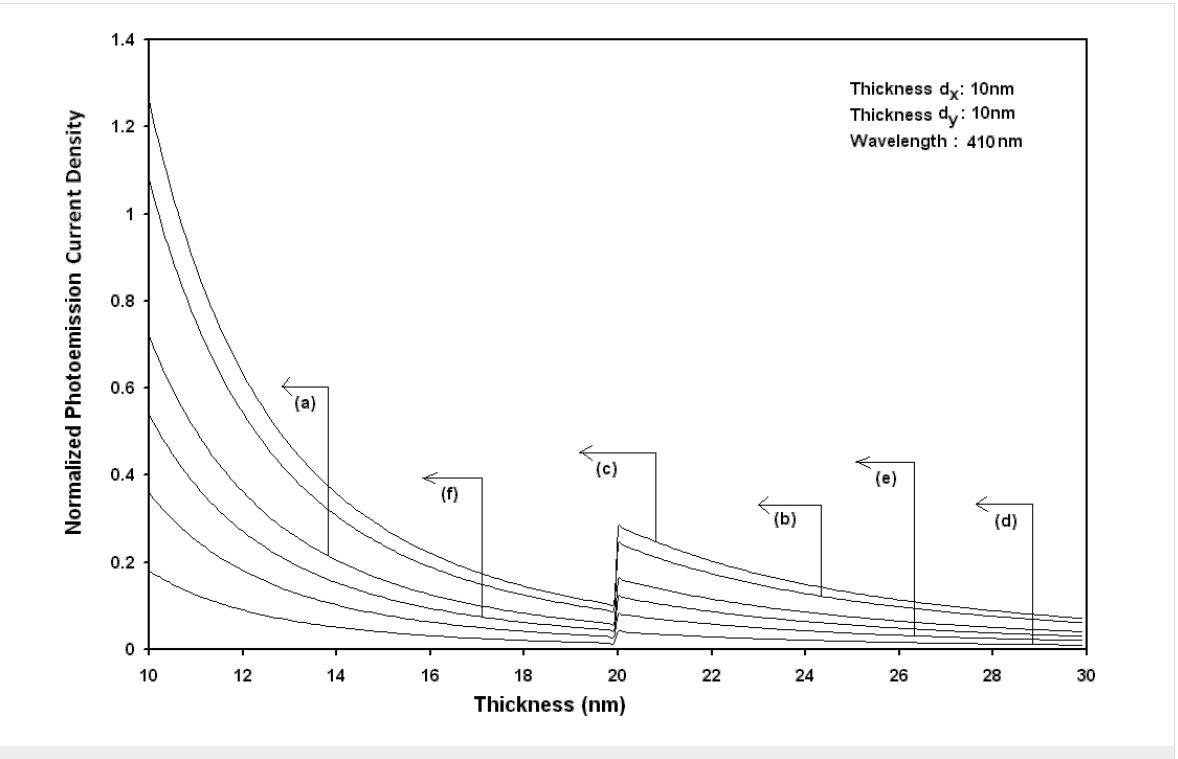
Figure 11: Plot of the normalized photoemission current density from quantum dot effective mass superlattices of HgTe/Hg 1 − x Cd x Te as a function of film thickness in which the curves (a), (b) and (c) represent the perturbed three and two band models of Kane and parabolic energy bands, respective- ly. The curves (d), (e) and (f) exhibit the corresponding plots of In x Ga 1 − x